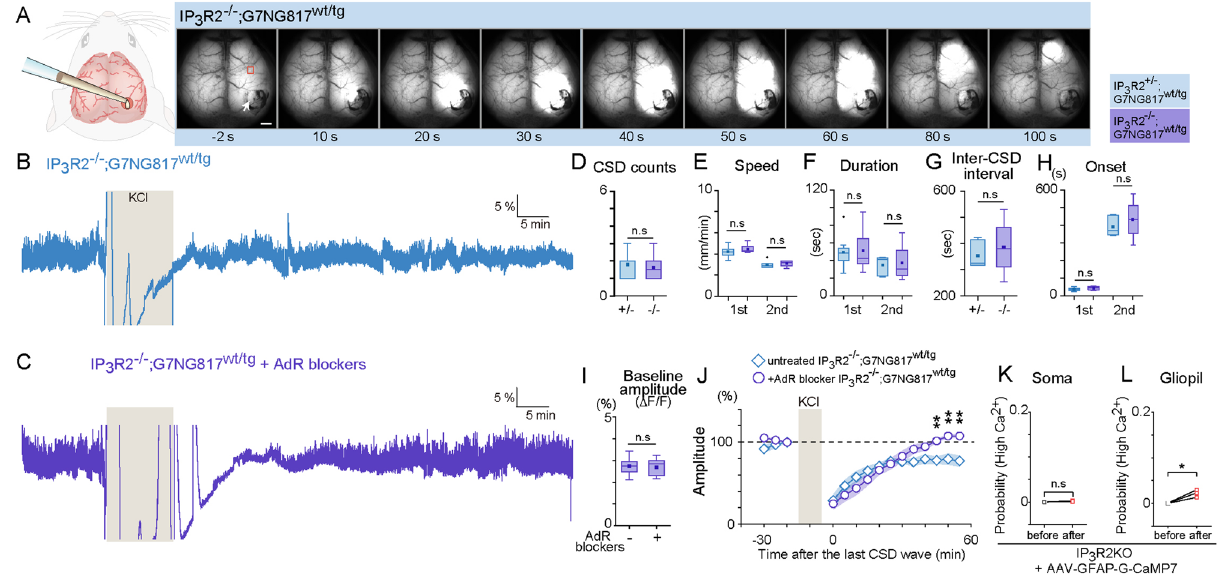
Figure 3. CSD propagation and neural activity recovery in IP 3 R2 KO mice. ( A ) Representative image of the time series of CSD propagation. Other than using IP 3 R2 −/− ;G7NG817 wt/tg double transgenic mouse as subjects, the experimental conditions are the same as in Fig. 1. Scale bar 1 mm. ( B ) Example trace of Ca 2+ activity of an ROI located ~ 2 mm anterior to the KCl application site (Black square indicated in A ). Note that neural activity does not recover completely within 50 min. ( C ) Similar Ca 2+ signal trace as ( B ). measured in an IP 3 R2 −/− ;G7NG817 wt/tg mouse pretreated with AdR blockers. ( D ) Comparison of CSD Ca 2+ wave number during 10 min KCl application between IP 3 R2 +/− ;G7NG817 wt/tg and IP 3 R2 −/− :G7NG817 wt/tg mice.